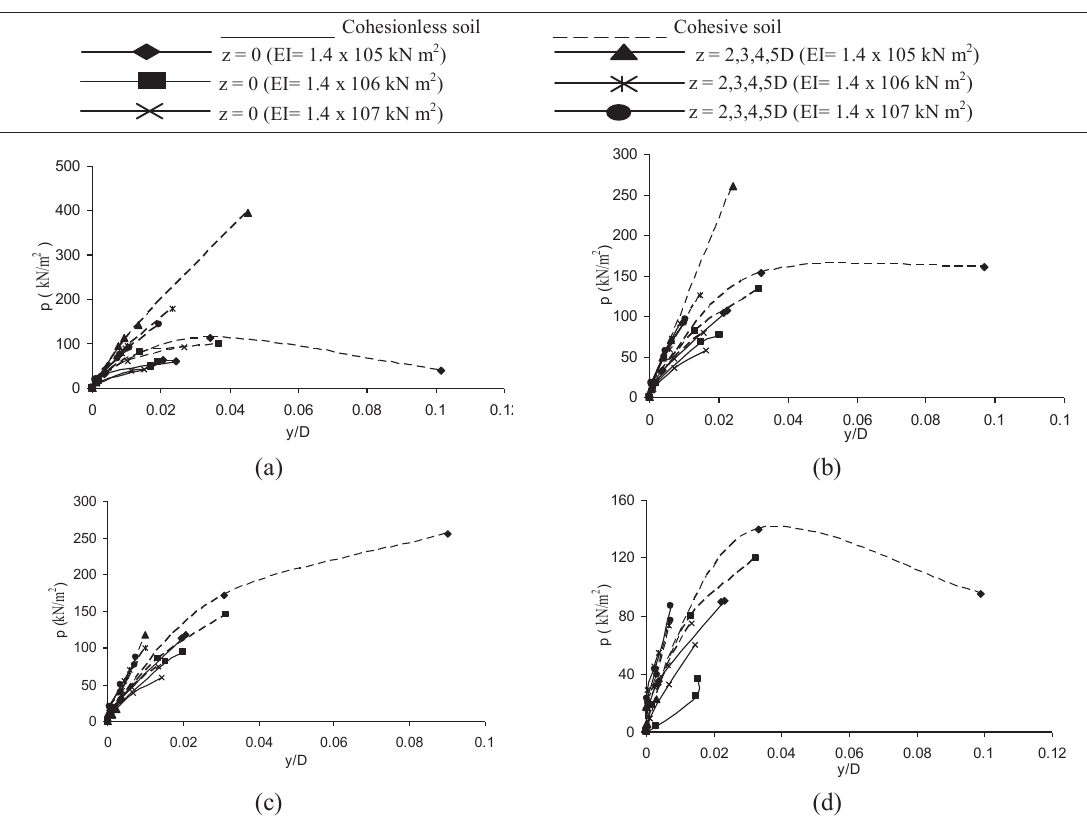
Figure 12: Predicted lateral tip displacement versus pile slenderness ratio under influence of lateral load intensities.